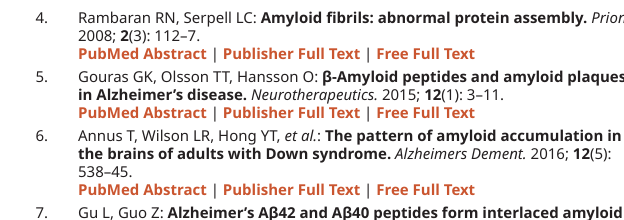
Figshare: Extended Data Workbook 5. Transcription Factors: TFs present in the AD-DS, Chr 21 genesets, https://doi.org/ 10.6084/m9.figshare.13106774.v1 43 . Figshare: Extended Data Workbook 6. APP Network File: APP protein-protein interaction network, https://doi.org/10.6084/ m9.figshare.13106777.v1 61